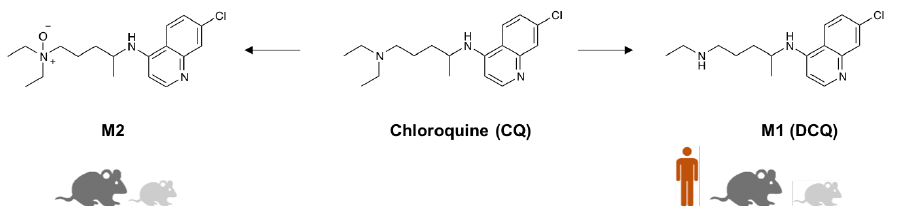
Figure 2. In vitro metabolite profiles of chloroquine (CQ) based on human, rat and mouse liver microsomal investigation. M1 : N-desethyl-chloroquine (DCQ), M2 : N-oxide derivatives of chloroquine.